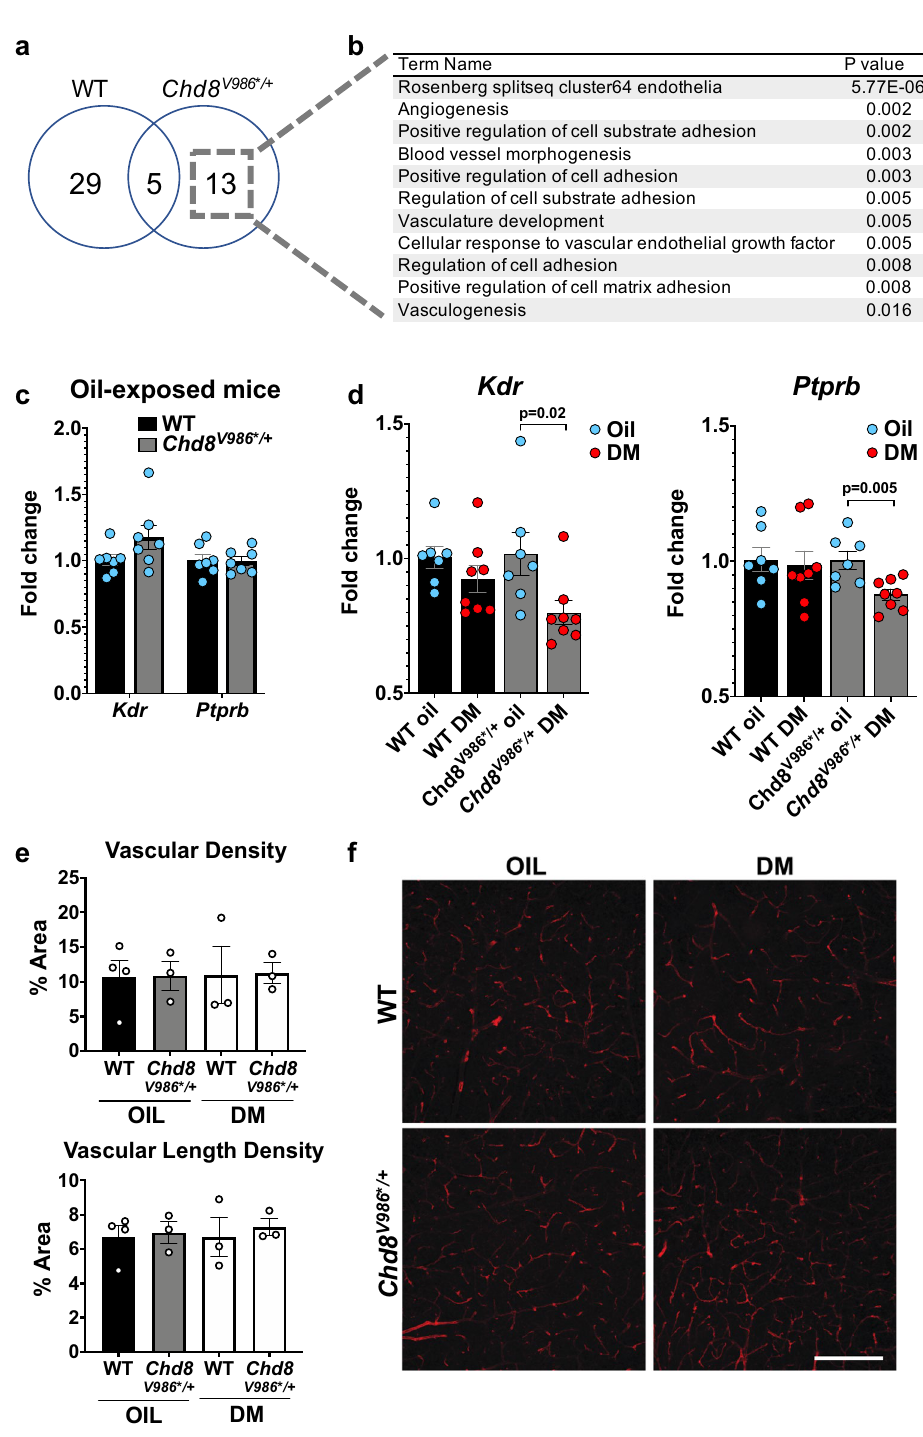
Figure 5. DM exposure is associated with altered cellular adhesion and vasculature development in Chd8 V986*/ + mice . (a) Number of DEGs associated with DM exposure identified with RNA-sequencing of cortical tissue from 12 month old mice pre- and postnatally exposed to DM. N = 10–12 mice per group. (b) DM-induced DEGs from Chd8 V986*/ + mice converge on downregulated pathways involved in cellular adhesion and vascular growth. (c) Cortical expression of vascular endothelial cell-related genes from RT-qPCR analysis of 12 month old WT and Chd8 V986*/ + mice exposed to oil. (d) Effect of DM exposure on cortical gene expression Kdr and Ptprb genes from RT-qPCR analysis of 12 month WT and Chd8 V986*/ + mice. N = 7–8/genotype/treatment. (e,f) Vascular density and vascular length density assessed with isolectin B4 staining and quantified. Each symbol represents the average of two 1024 × 1024 pixel images obtained from different cortical tissue sections for one brain (n = 3–4). Scale bar represents 200 μm. Data represent means ±